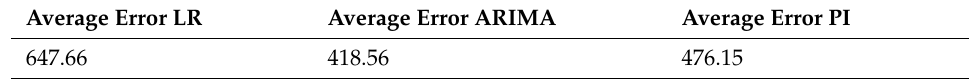
Table 13. Average error of each regression model.